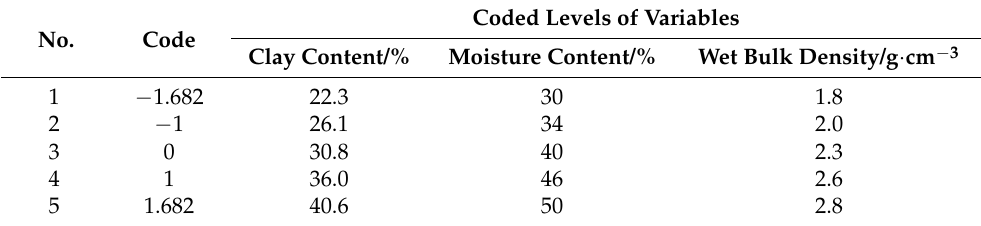
Coded Levels of